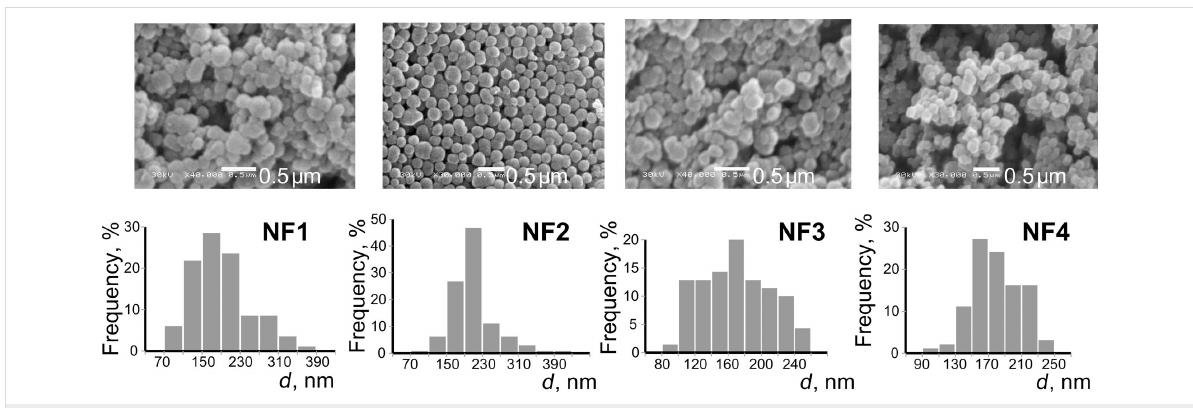
atoms of residual ethoxysilyl groups absent in the spectra of samples obtained at 50